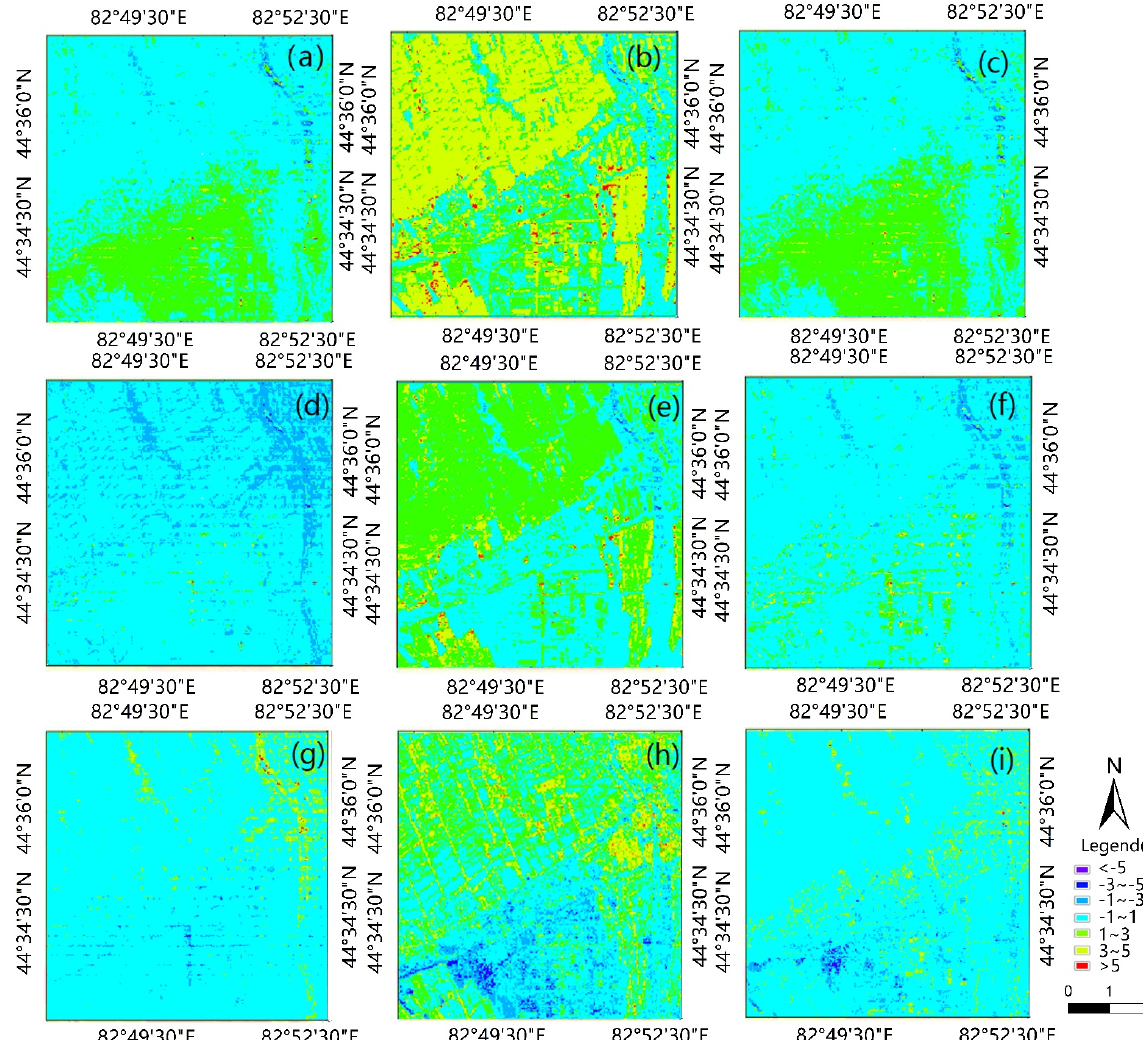
Figure 8. Spatial distribution of the differences between the Landsat-8- and GF-6-retrieved LST dataset and downscaled results obtained using three different downscaling methods with different GF-6 bands on 26 August 2019 (in units of K). ( a ) DisTrad LST GF 6_ Nir , ( b ) DisTrad LST RE 1 , ( c ) DisTrad LST RE 2 , ( d ) TsHARP LST GF 6_ Nir , ( e ) TsHARP LST RE 1 , ( f ) TsHARP LST RE 2 , ( g ) MIRF LST GF 6_ Nir , ( h ) MIRF LST RE 1 , ( i ) MIRF LST RE 2